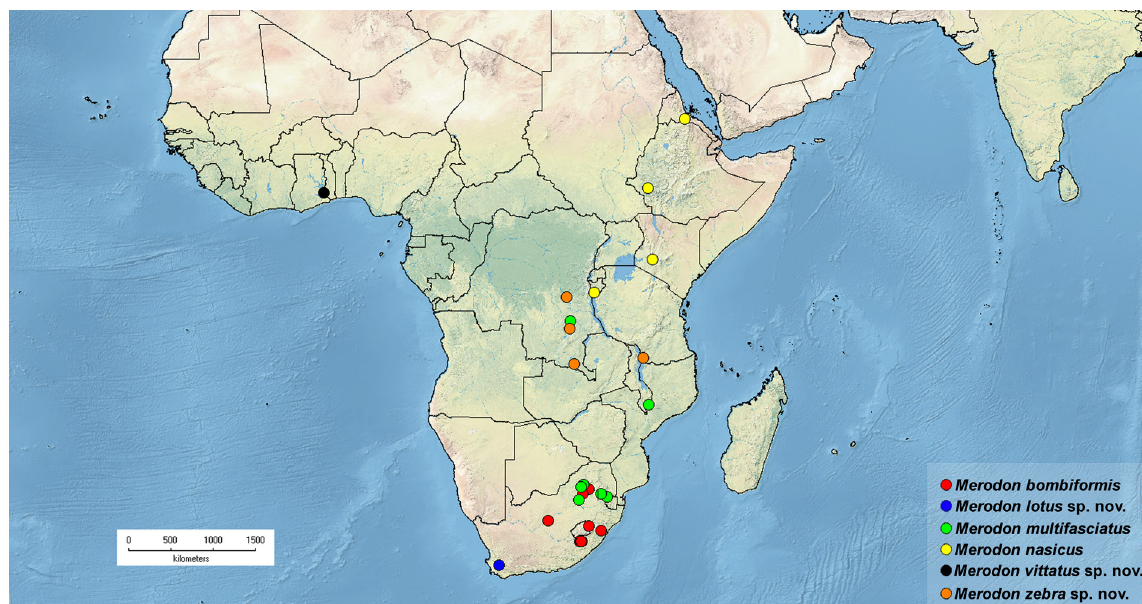
Fig. 1. Distribution map of the Merodon bombiformis species